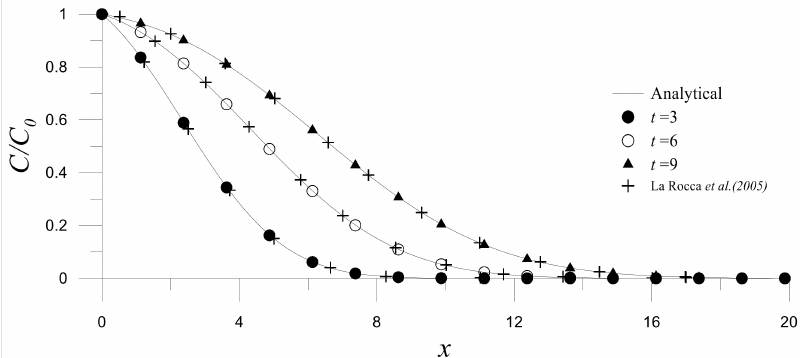
Figure 9. Comparisons between the numerical results of Hermite MAPS, the analytical solutions and the results in the literature for Example 2.